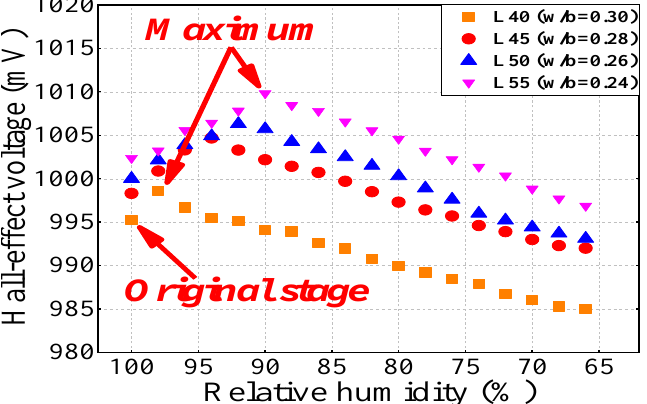
Figure 8. The relationship between Hall effect voltage and relative humidity.